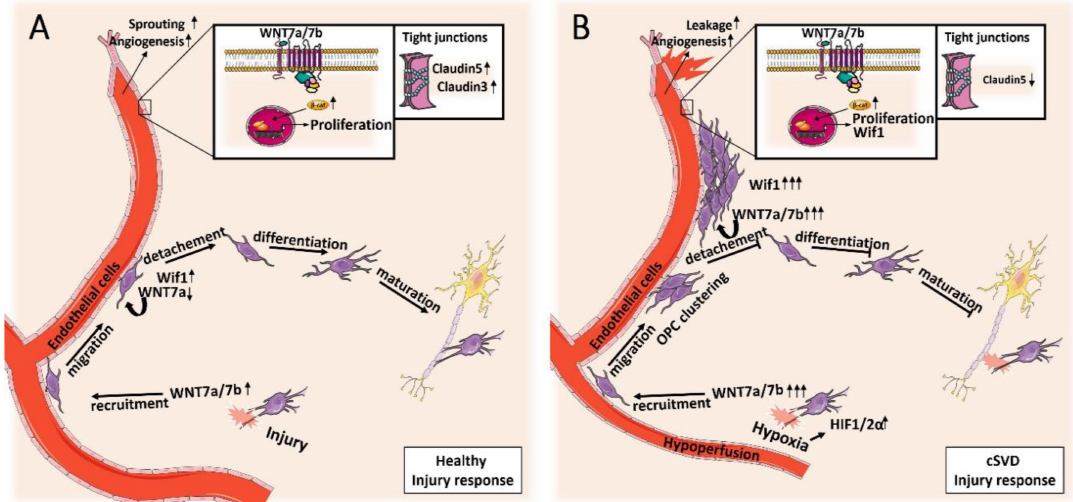
Figure 3. Schematic overview of the proposed contribution of WNT / β -catenin signaling in cSVD. ( A ) In a healthy situation, hypoxic injury induces WNT7a and WNT7b signaling in OPCs / OLs to promote the recruitment of new OPCs at sites of demyelination. OPCs migrate to the site of injury partly by